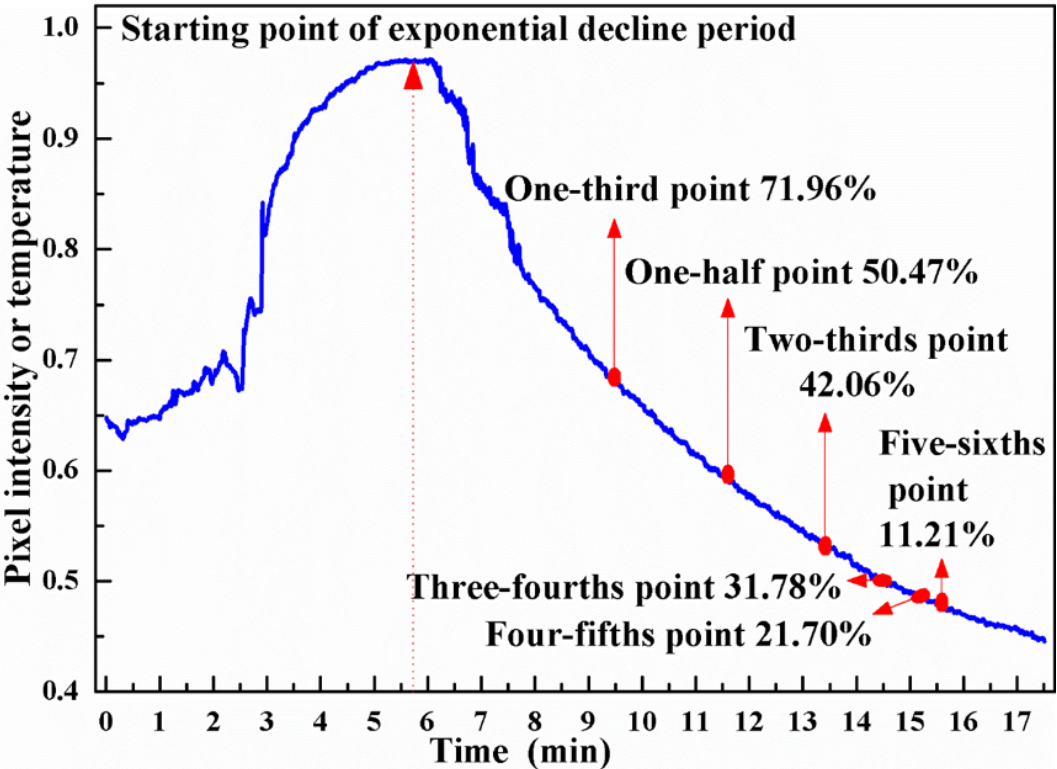
Figure 8. Accuracy of estimating departure time at the different capture time